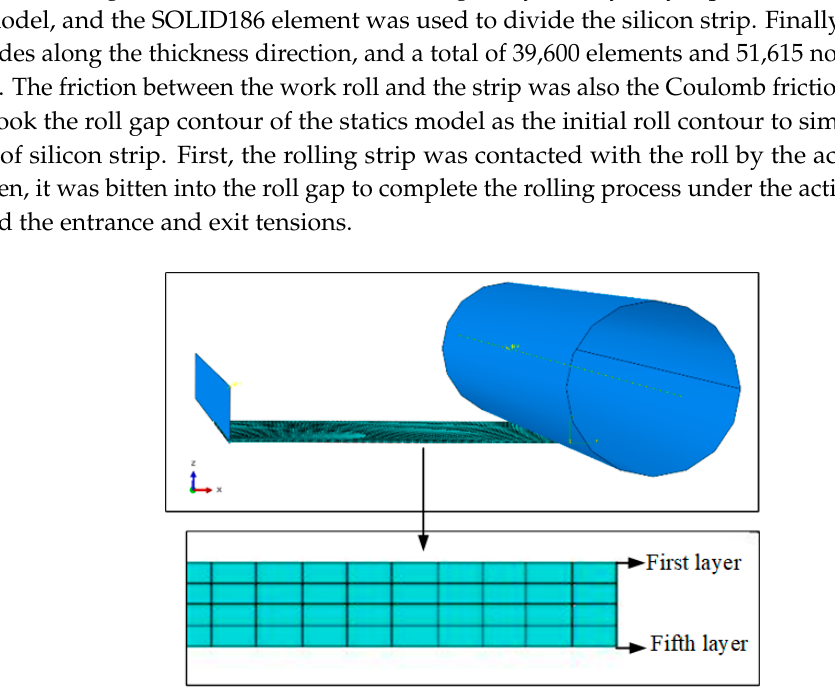
Figure 3. Dynamics model of the rolling process.